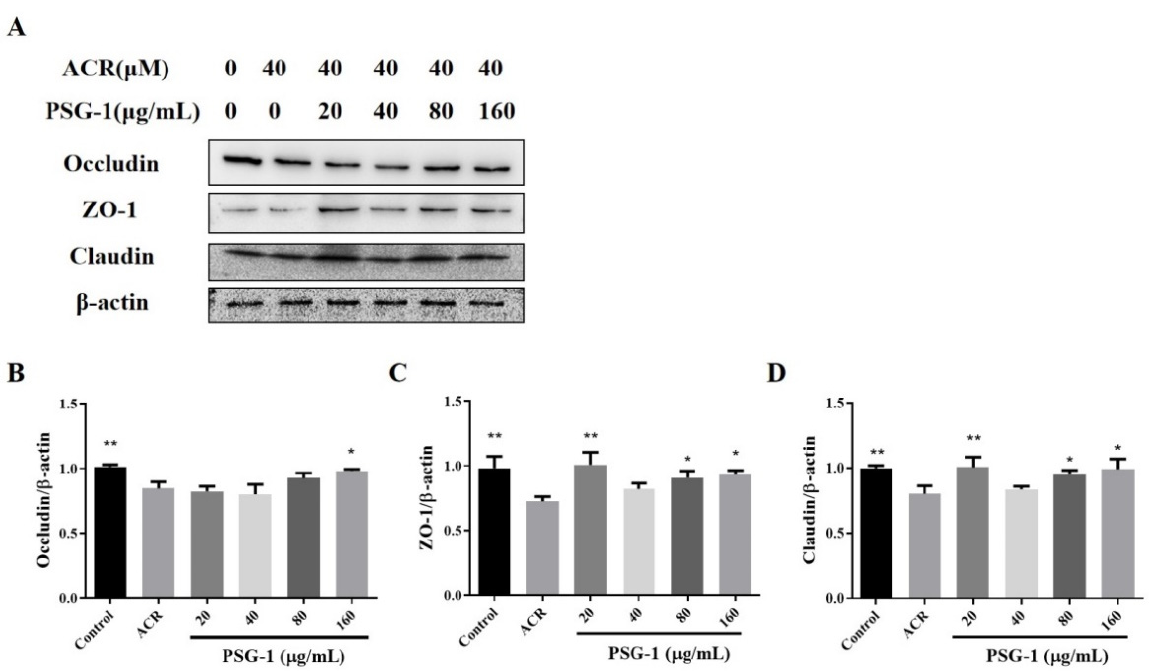
Figure 3. PSG-1 regulated the expression of TJ-related proteins in acrolein-induced IEC-6 cells. ( A ) The protein levels of occludin, claudin, and ZO-1. ( B – D ) Relative intensities of these proteins. Values are means ± SD ( n = 3), * p < 0.05, ** p < 0.01 compared with the acrolein group.